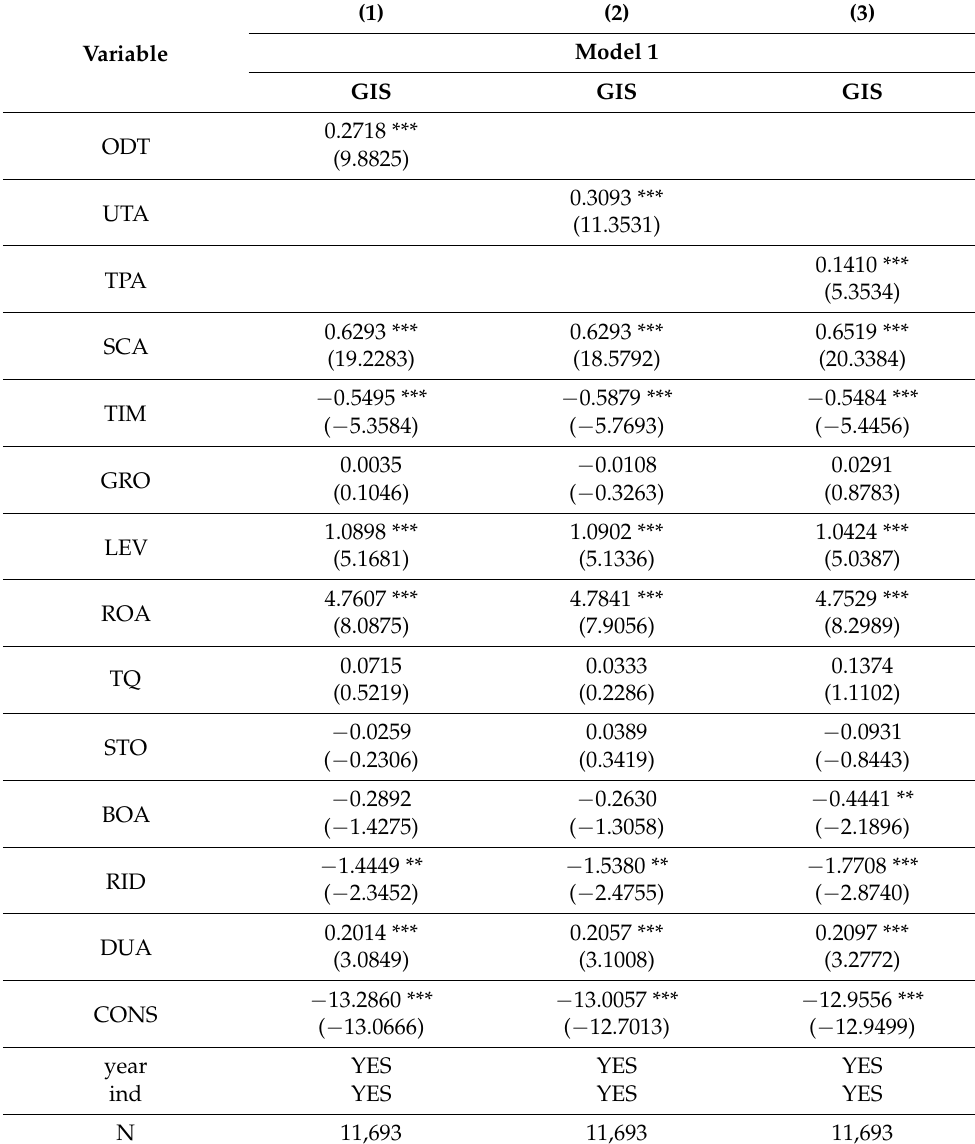
Table 13. Robustness test results